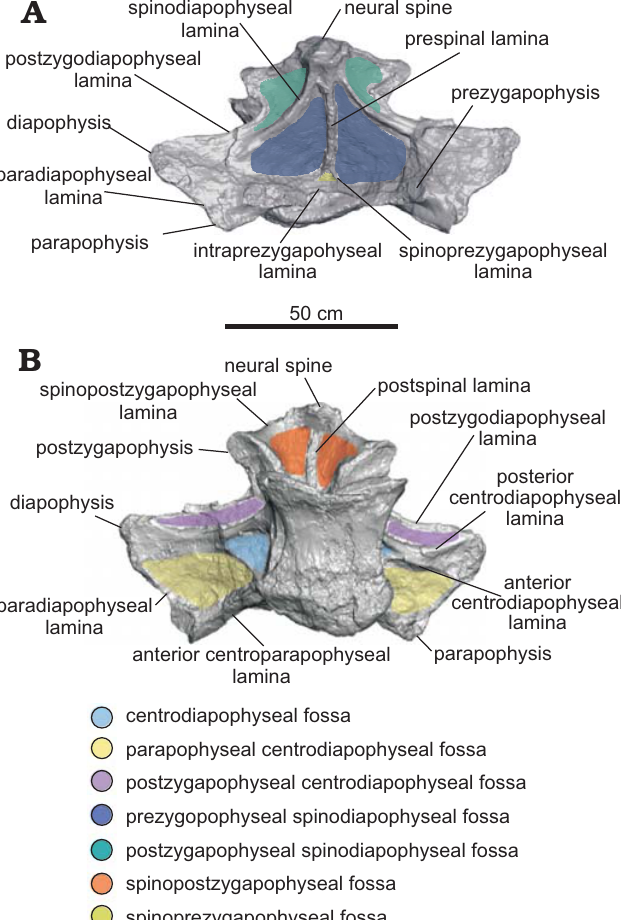
Fig. 4. Most anterior dorsal vertebra preserved of titanosaurian sauropod Dreadnoughtus schrani Lacovara, Lamanna, Ibiricu, Poole, Schroeter, Ullmann, Voegele, Boles, Carter, Fowler, Egerton, Moyer, Coughenour, Schein, Harris, Martínez, and Novas, 2014, MPM-PV 1156?-4 (estimated as the ~4 th dorsal vertebra), from Santa Cruz Province, Argentina; middle– late Campanian to early Maastrichtian; in dorsal ( A ) and ventral ( B ) views. Colours indicate neural arch